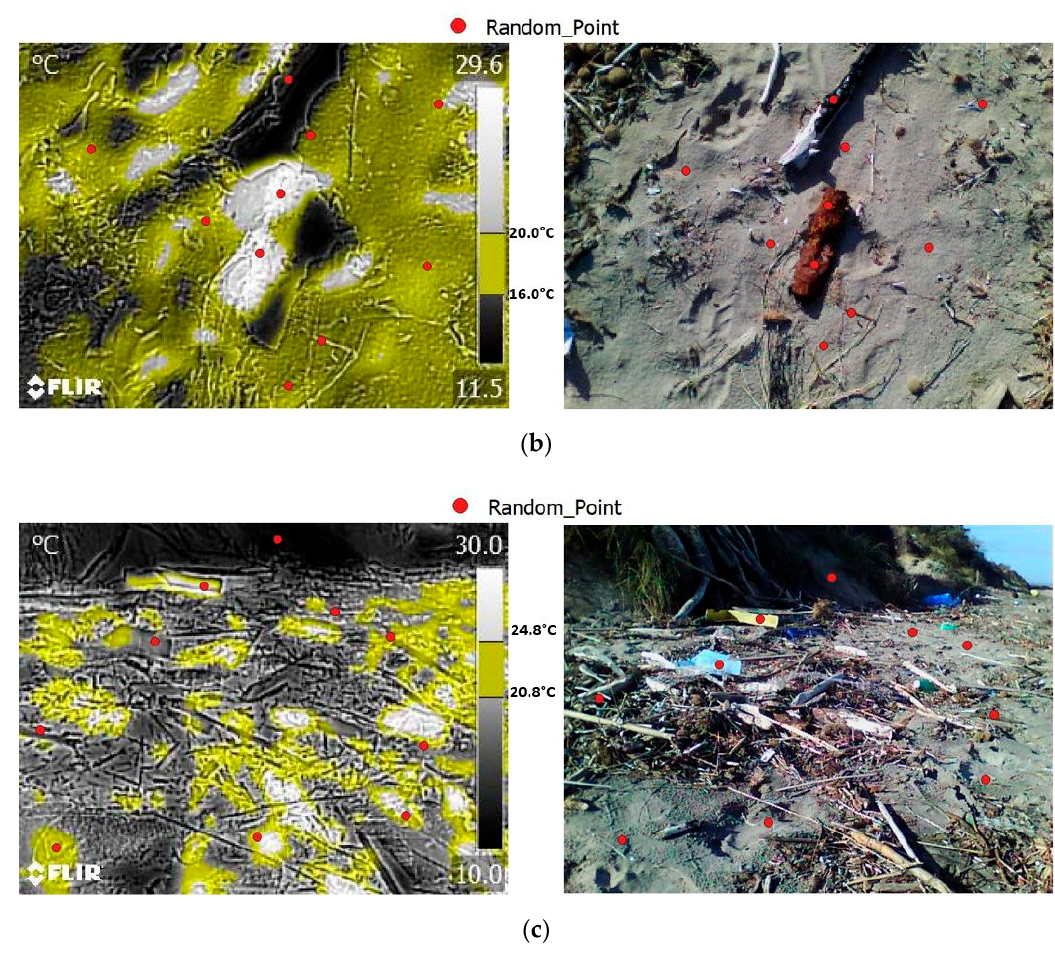
Figure 9. Afternoon acquisition: thermal image (on the left) and RGB image (on the right). Randomly selected points (in red). The yellow pixels in the thermal image represent the sandy soil surface identified by the application of the empirical Equation (2). Plastic bottles and bags can be seen in ( a , c ) and rusty bottles in ( b ). Table 4. Correspondence between the material detected in the thermal image and the RGB image in the selected points (afternoon).